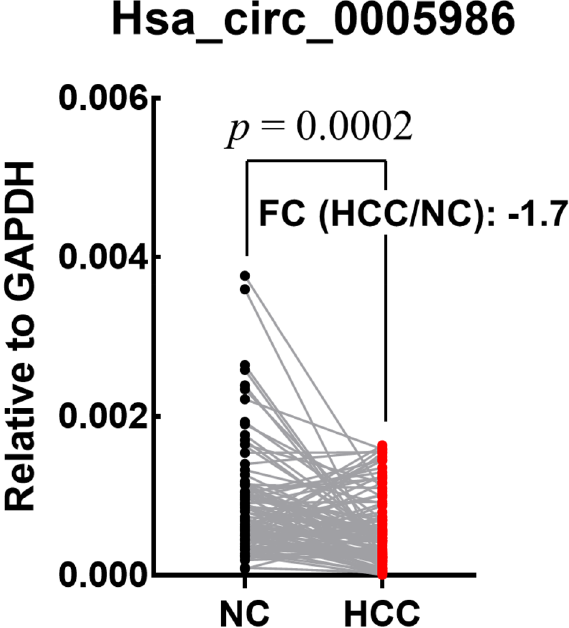
Figure 2. Dot-plot of hsa_circ_0005986 expression in non-cancerous (NC) and hepatocellular carcinoma (HCC) tissues. Hsa_circ_0005986 expression in HCC tissues was lower than [fold change (FC): -1.7] that in NC tissues ( p =